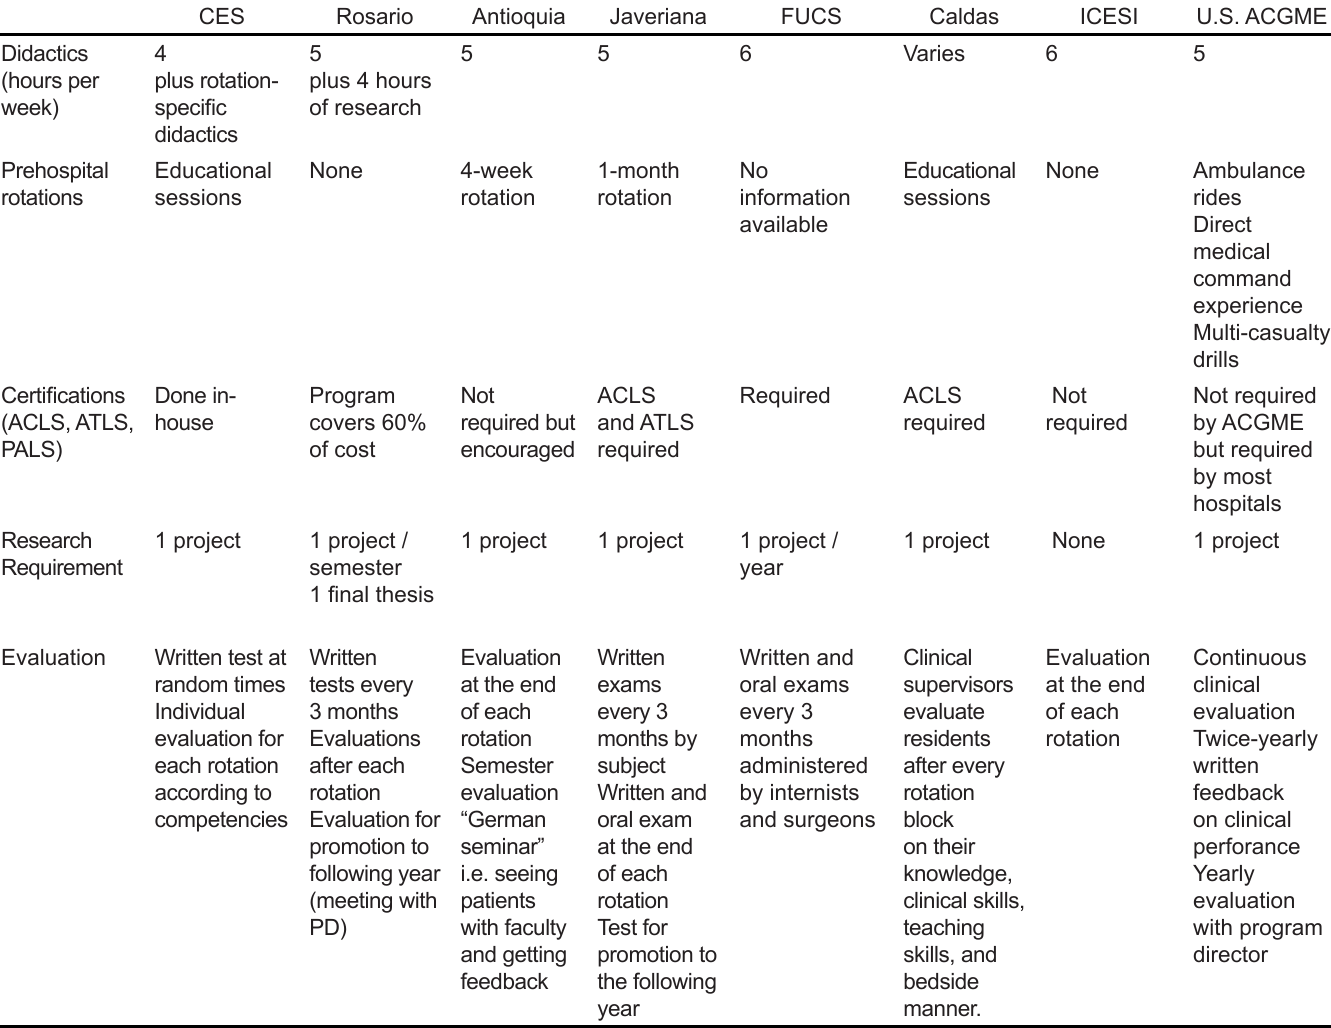
Table 3. Didactics, research, and resident evaluation. The seven EM residency programs in Colombia differ in didactics, research and resident evaluation requirements. The U.S. ACGME* requirements are included for